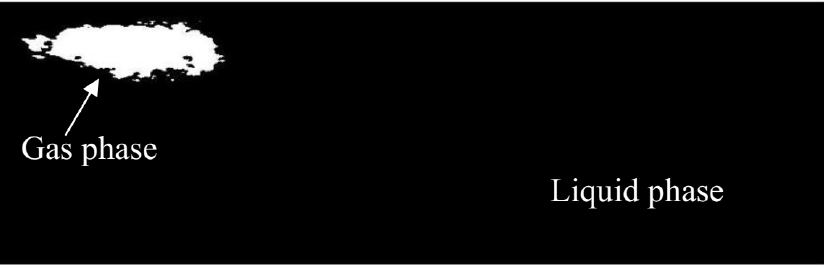
Figure 12. Probability density function of inclined upward by 20°.